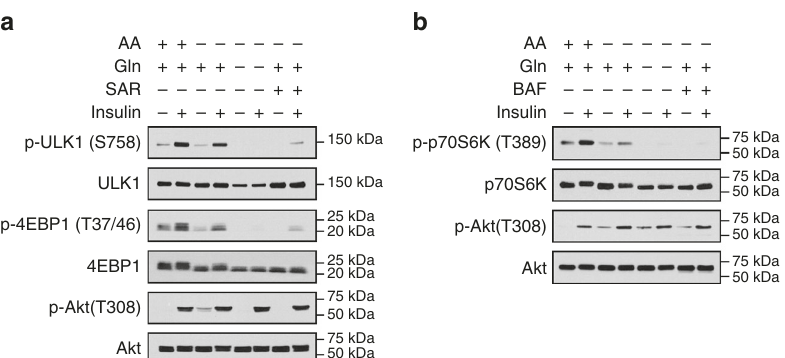
Fig. 5 Glutamine and autophagy sustain insulin-induced mTORC1 signaling during amino acid starvation. a HepG2 cells were pre-incubated for 30 min in EBSS with amino acids. Cells were then starved of amino acids in the presence or absence of glutamine (4 mM) with or without SAR405 (5 µ M) for 5 h, followed by insulin (50 nM) stimulation for an additional 30 min. Changes in mTORC1 activity were assessed by immunoblotting of p-4EBP1 and p-ULK1. Insulin stimulation was assessed by immunoblotting of p-Akt. b C2C12 myotubes were pre-incubated for 30 min in EBSS with amino acids. Myotubes were then starved of amino acids in the presence or absence of glutamine (4 mM) with or without ba fi lomycin A1 (200 nM) for 5 h, followed by insulin (50 nM) stimulation for an additional 30 min. Changes in mTORC1 activity were assessed by immunoblotting of p-p70S6K. Insulin stimulation was assessed by immunoblotting